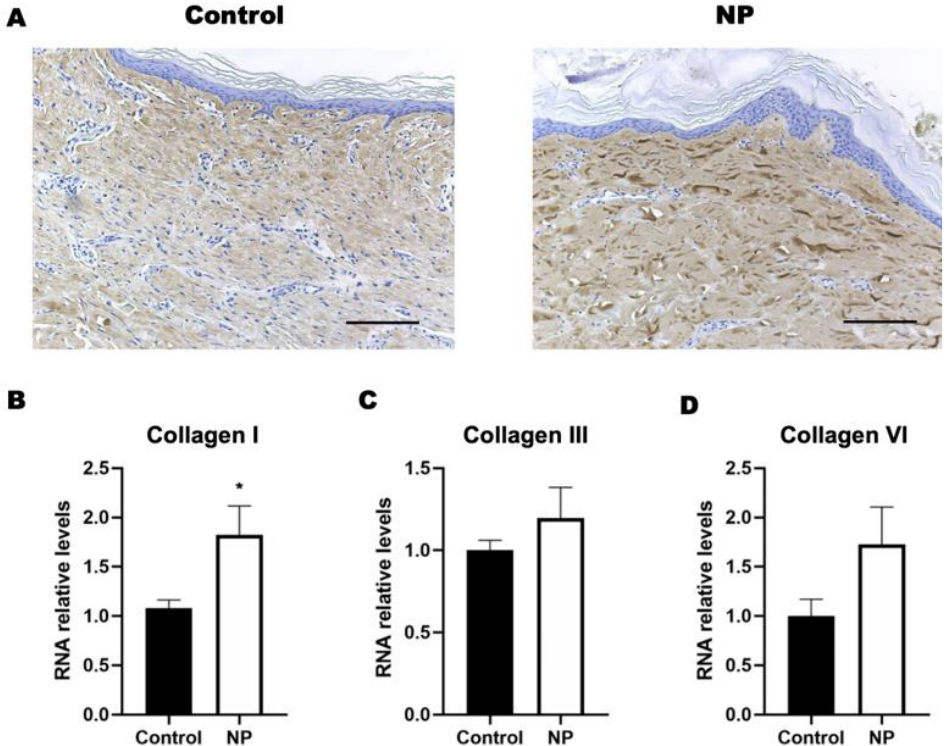
Figure 4. The collagen expression in porcine skin tissue following negative-pressure treatment. ( A ) Histological staining of collagen type I in the control and NP groups. ( B – D ) The gene expression of collagens I, III, and VI in the control and NP groups (n = 4). Scale bar: 200 µm. * p < 0.05. Error bar: standard error.